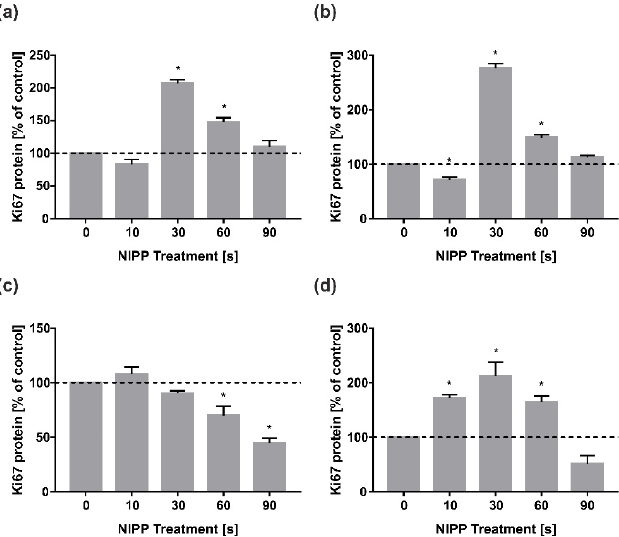
Figure 2. Effects of NIPP on Ki67 protein levels in HGF and HGK at 24 h and 48 h, respectively. Protein levels were related to total protein and normalised to control. Treatment was performed for the indicated times: ( a ) Ki67 concentration in HGF cell lysates at 24 h; ( b ) Ki67 concentration in HGF cell lysates at 48 h; ( c ) Ki67 concentration in HGK cell lysates at 24 h; ( d ) Ki67 concentration in HGK cell lysates at 48 h. n = 6. * statistical significance compared to control (0 s) ( p < 0.05).